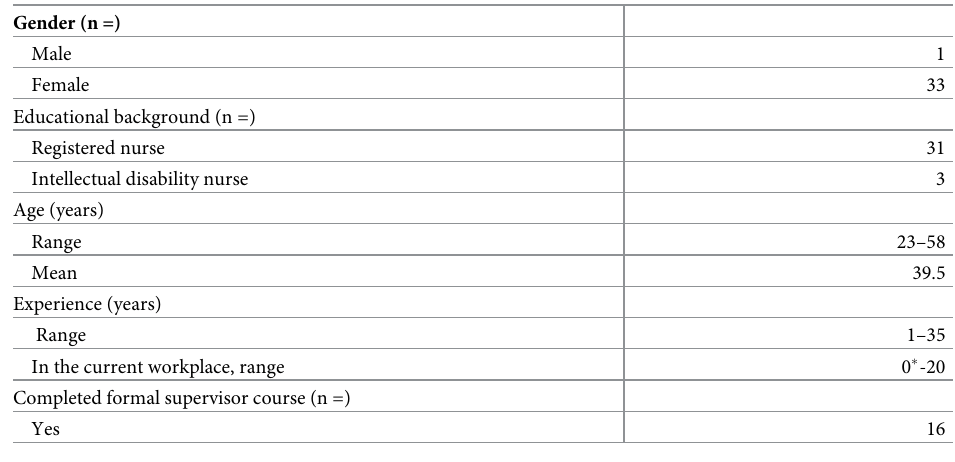
Table 2. Participants’ general